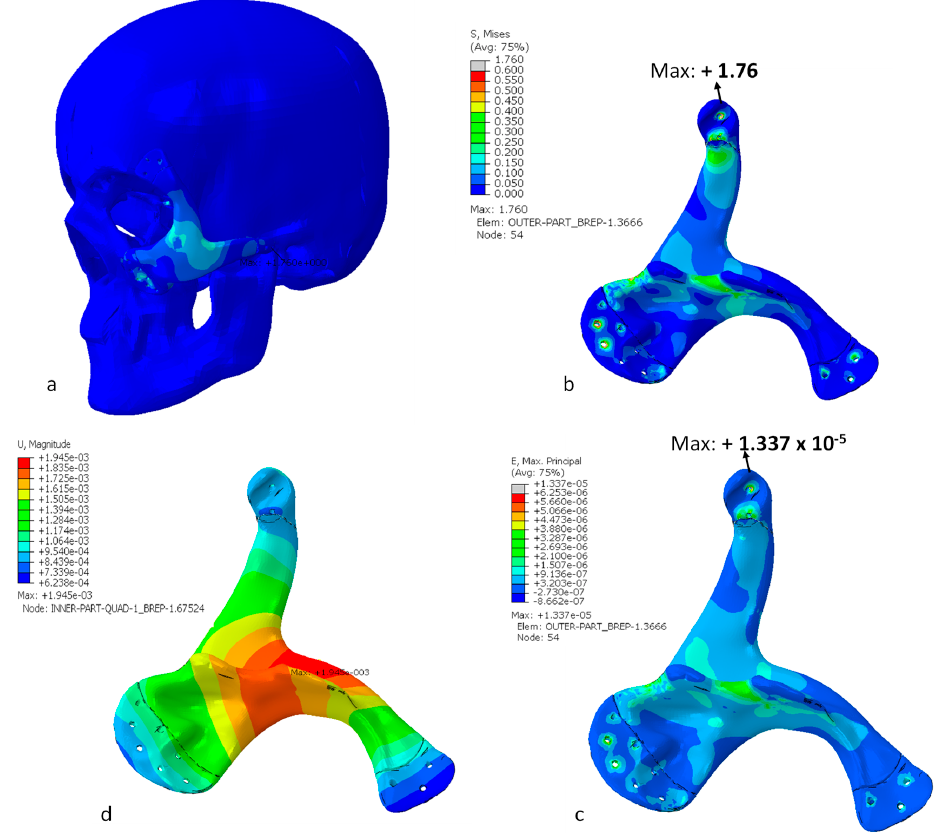
Figure 15. ( a ) Mises stress distributions for the zygomatic implant (MPa), ( b ) Mises stress distributions for the zygomatic implant (MPa), ( c ) maximum principal strain for the zygomatic implant and ( d ) total displacement contour for the zygomatic implant (mm).